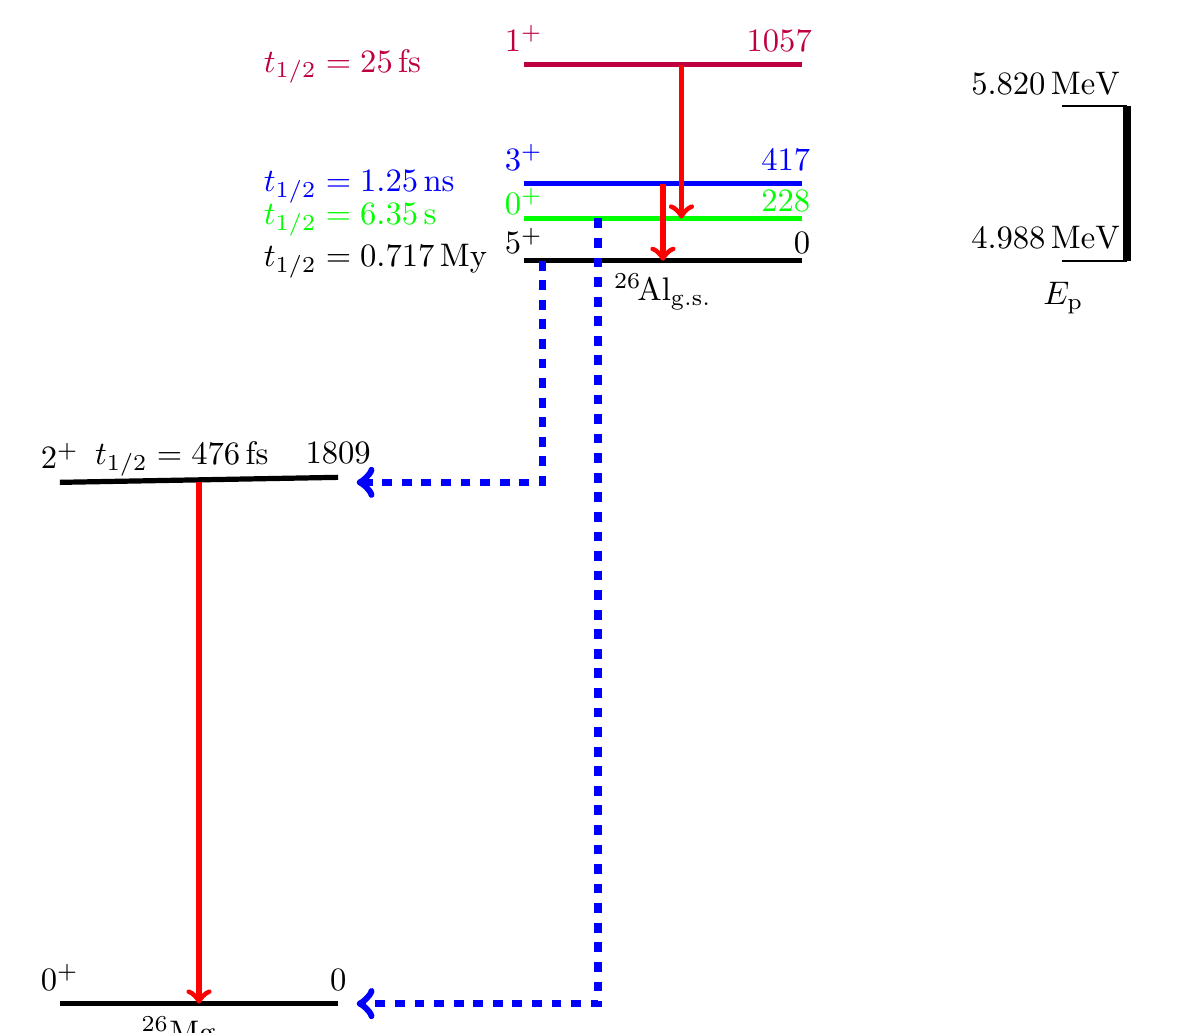
Figure 1. Simplified decay pattern of 26 Al including the lowest four states. The two β + decay branches are depicted with the blue dotted lines. The γ -transitions between the states are indicated with red arrows, such as the 417 keV state which solely decays into the ground state 26 Al g.s. To the right of the level scheme, the proton energy range 4.988 MeV 5.820 MeV E p ≤ ≤ surveyed for the reaction 26 Mg ( p, n ) 26 Al by Skelton et al. is depicted [18].